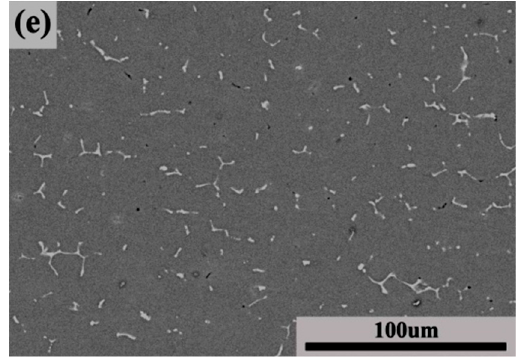
Figure 7. BSE micrographs of welded joints after PWHT with solution at 490 °C for different times followed by aging at 120 °C for 24 h: ( a ) 40 min; ( b ) 60 min; ( c ) 80 min; ( d ) 100 min; and ( e ) 120 min.